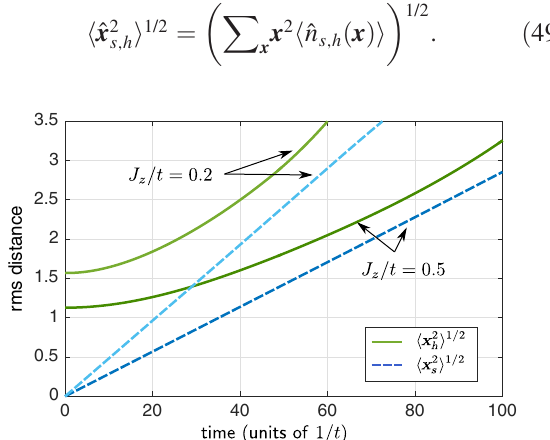
FIG. 16. The root-mean-square radii h ˆ x 2 i 1 /2 of the spinon and s;h x Þi are calculated as function of hole density distributions h ˆ n s;h ð time, for S ¼ 1 /2. We start from a localized spinon and the holon is initially in its rovibrational ground state. The dynamics of the hole distribution is dominated by the ballistic expansion of the spinon at long